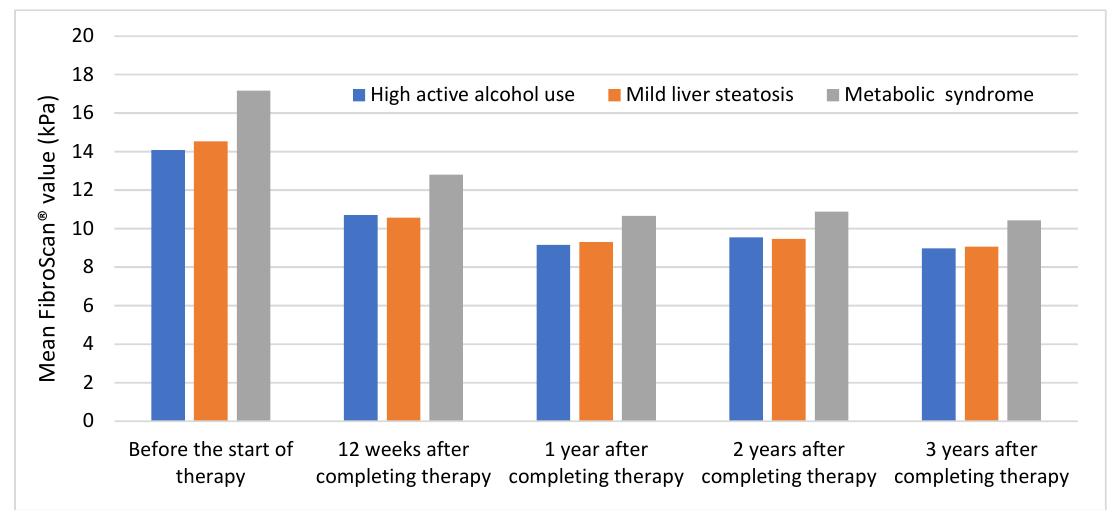
Figure 4. Trend of mean FibroScan ® values in patients with high active alcohol use, mild liver steatosis, and metabolic syndrome throughout the follow-up period.